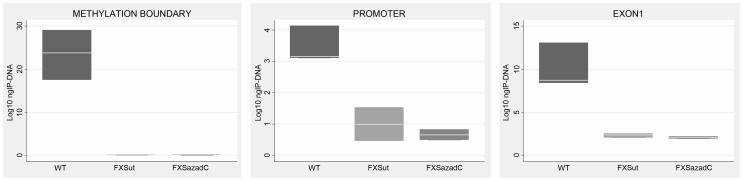
CTCF binding on FMR1 locus through ChIP analysis after pharmacological demethylation.ChIP assay of CTCF binding to FMR1 methylation boundary, promoter and exon 1 region after a 7-day treatment with [1 µM] 5-azadC on the S1 (FXS) lymphoblastoid cell line with 450 CGGs. After the pharmacological treatment we observed 25% of FMR1 transcriptional reactivation. Box plots represent the amount of DNA bound by CTCF in untreated WT lymphoblasts, untreated FXS (FXSut) and FXS treated with 5-azadC (FXSazadC) cell lines. Note that the amount of IP-DNA (ng) is indicated in logarithmic scale. ChIP experiments included negative controls performed by IgG immunoprecipitation and no template control (not shown).